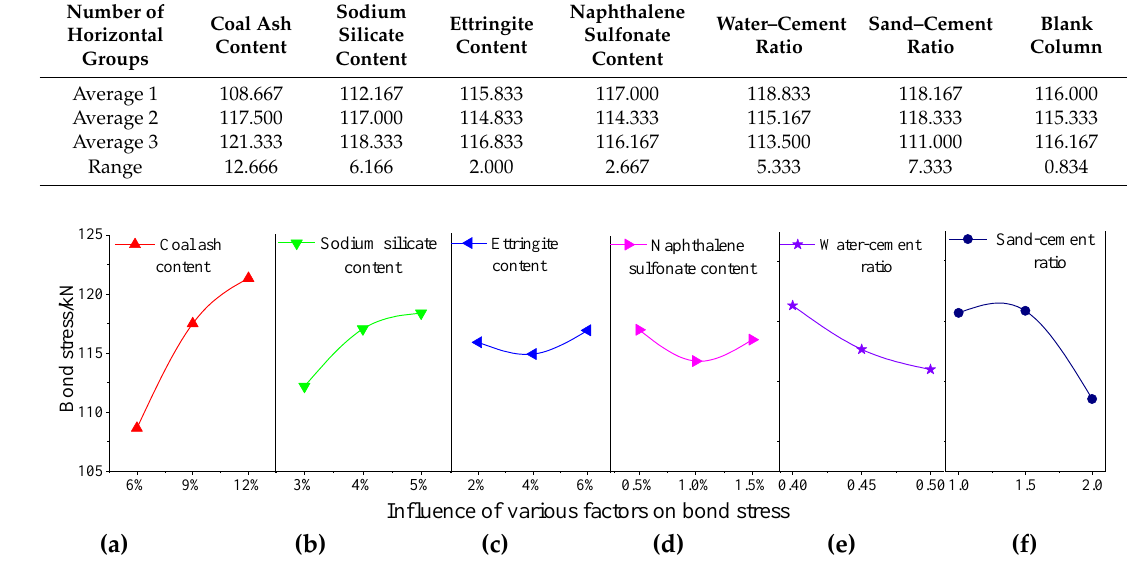
Figure 10. Trend diagram of the effect of various factors on the bond stress. ( a ) coal ash content; ( b ) sodium silicate content; ( c ) ettringite content; ( d ) naphthalene sulfonate content; ( e ) water–cement ratio; and ( f ) sand–cement ratio.